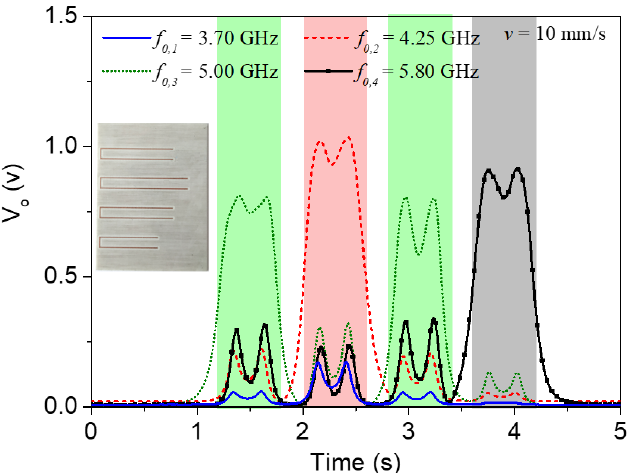
Figure 12. Envelope functions for the four frequencies corresponding to the (second) resonances of the four C-shaped resonators, for the tag depicted in the